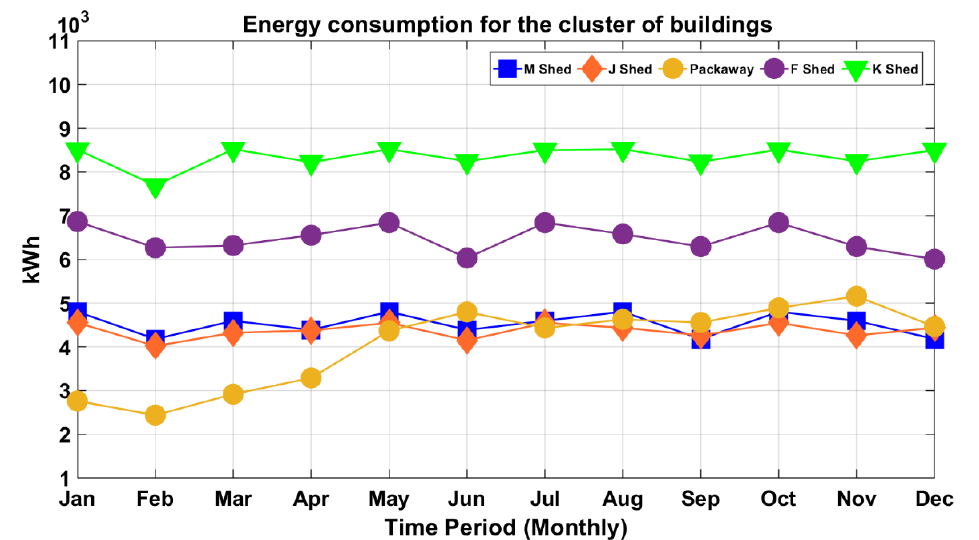
Figure 7. Total power consumption of the buildings in the Milford Haven port.